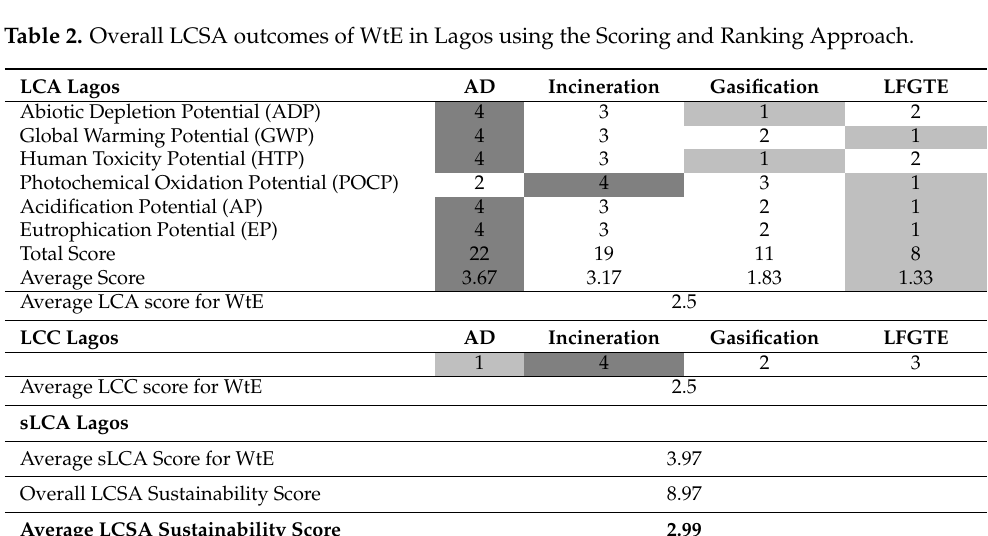
Box fill indicates ranking of impact: Dark Grey = Best Impact Category per WtE system, Light Grey = Worst Impact Category per WtE